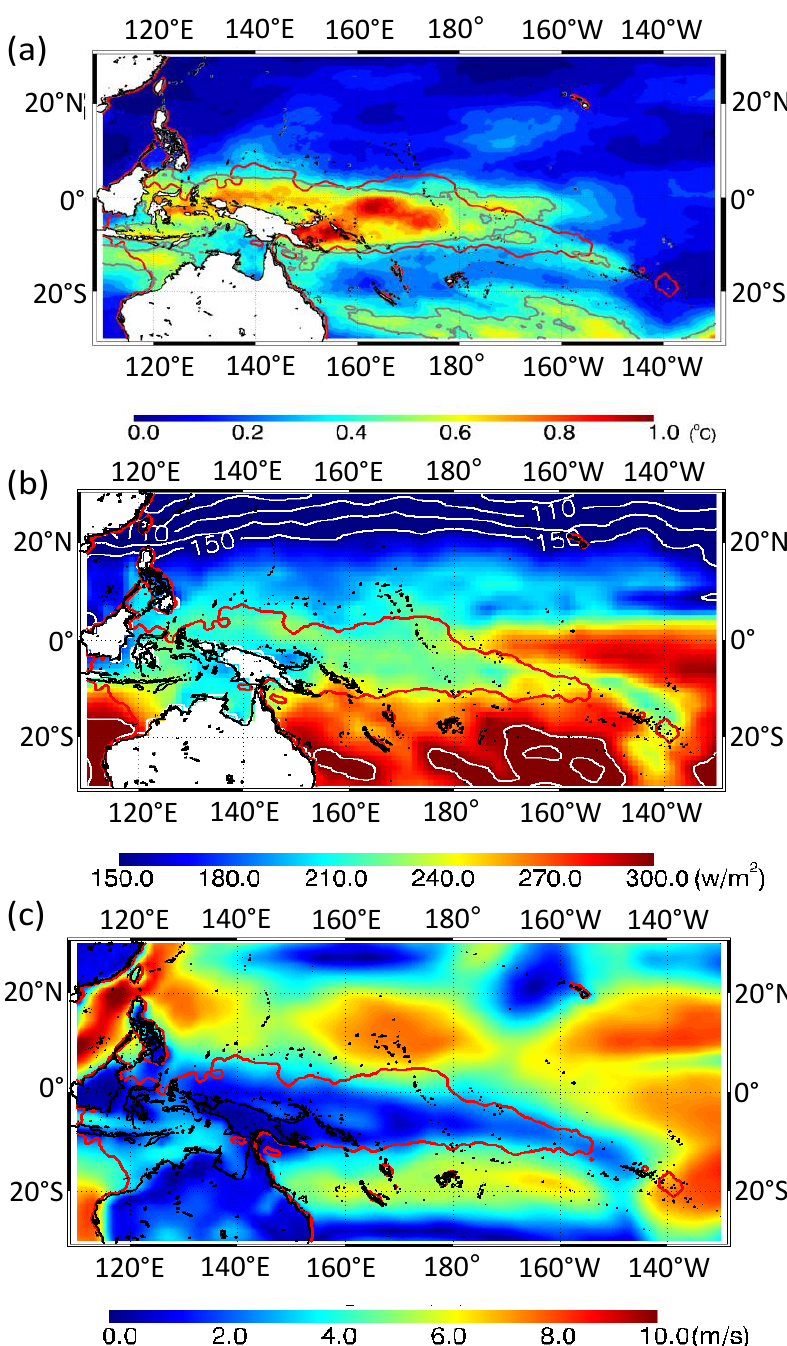
Figure 5. ( a ) δ SST map, ( b ) solar radiation map and ( c ) wind speed map of HE041216. The red contour denotes the area of HE041216. The gray contour in ( a ) denotes the δ SST of 0.5 ◦ C. The white contour in ( b ) denotes solar radiation of less than 150 W / m 2 and more than 300 W / m 2 . For the climatological analysis, we show the distribution of SST during the HE period for 2003– 2011 in the western equatorial Pacific (Figure 6). Figure 6a shows that high SST of more than 0.4 C is distributed from 10 S to 10 N along the northern coast of New Guinea Island until 170 W. The high SST distribution is collocated with the area of HE frequency occurrence of more than 5%. The seasonal change also shows the same tendency (Figure 6b,c). The northward (southward) shift of the area of high SST distribution is followed by the northward (southward) shift of the area of high HE frequency occurrence during boreal summer (winter). This indicates the strong relation between HE and SST distribution.